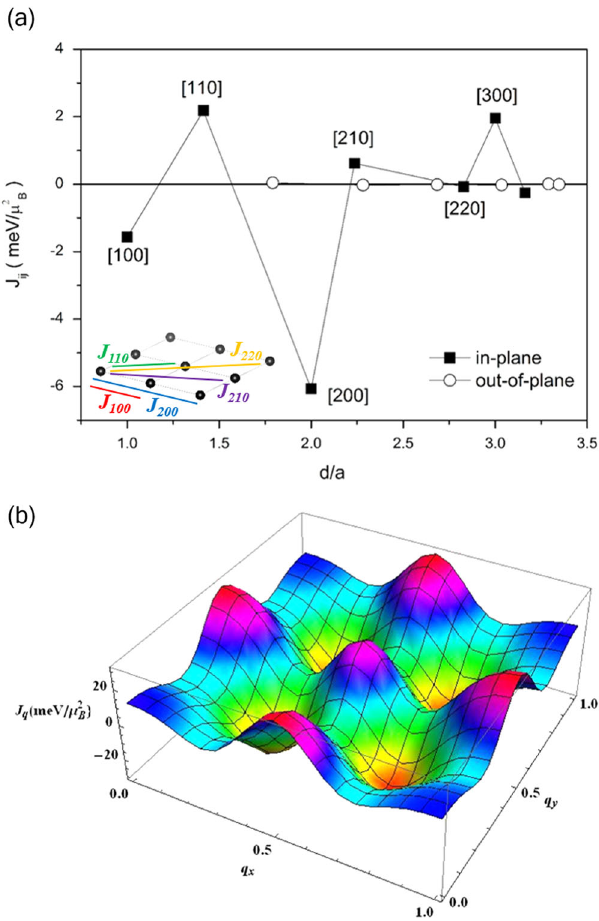
Fig. 1 Calculated exchange interactions up to the 7th coordination sphere in Sr 2 RuO 4 . a The distance dependence (in terms of planar lattice constant) of isotropic exchange interactions for in-plane ( fi lled square ) and out-of-plane ( open circle ). b The Fourier transform of the exchange interactions shown in the panel